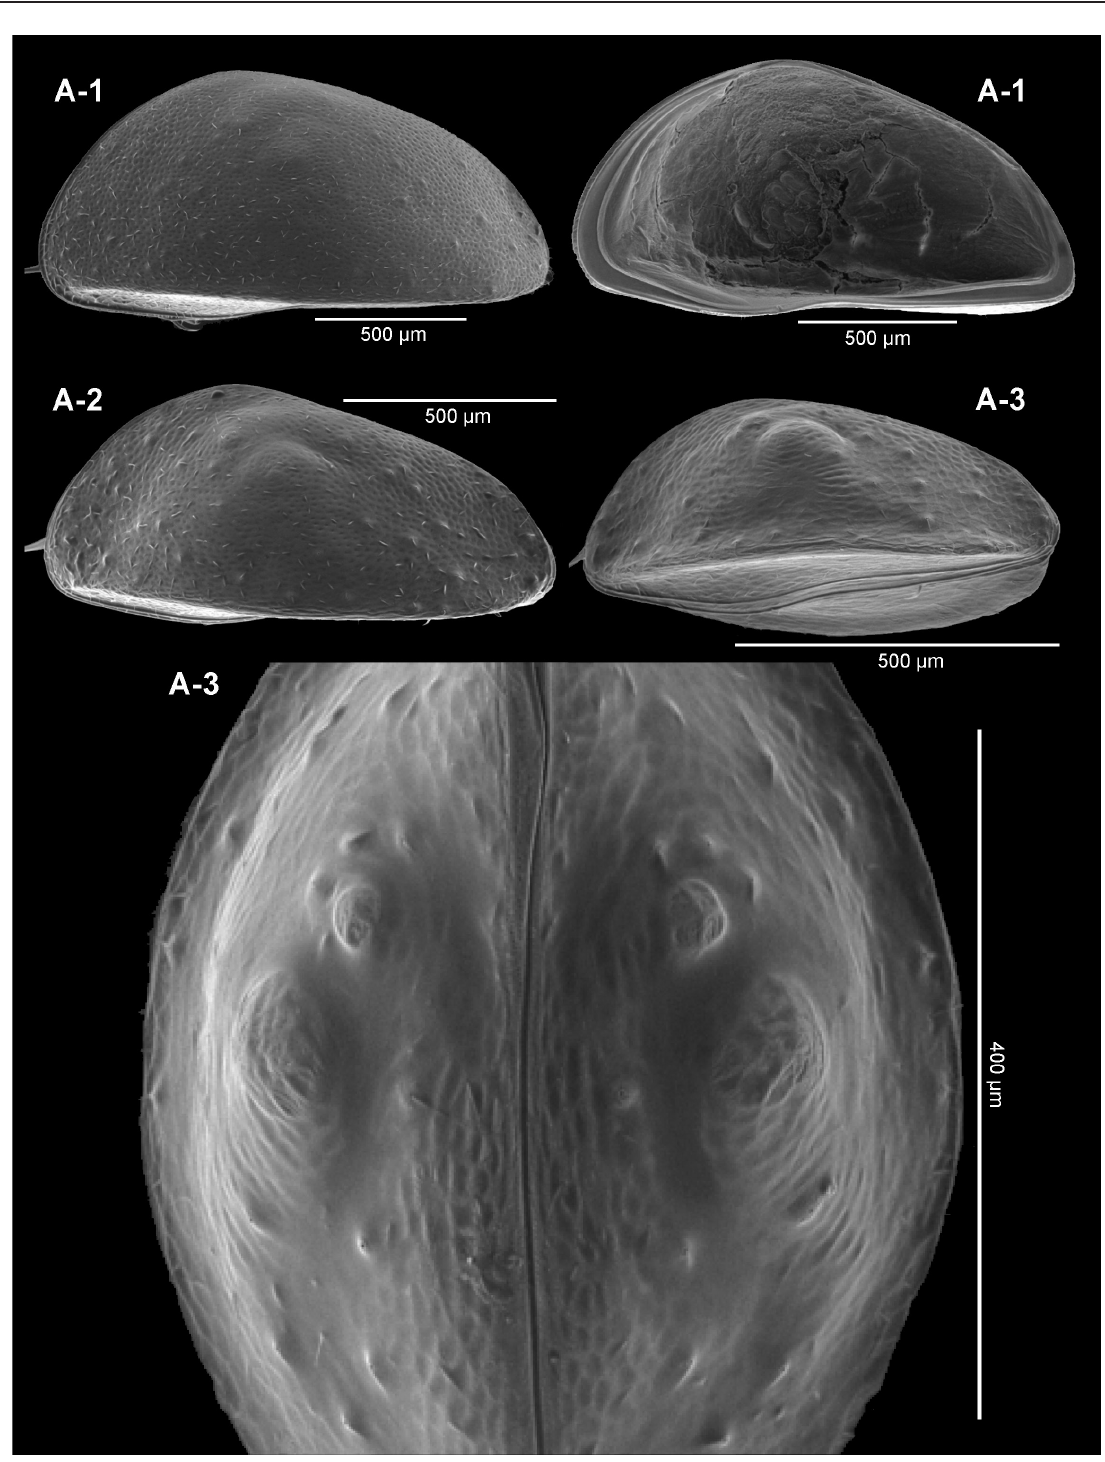
Fig. 12. Bennelongia sp. 414 nov. sp. from locality CB35a at Wooramel Station (Halse et al . 2000). All views are external, except for the right valve displayed at the top right hand corner. As for Figure 11, note that the domes and cones are much more discrete. This is particularly obvious in the bottom image that displays a dorsal view of the carapace of an A-3 juvenile. Note also that the internal view does not show a depression at the location of the dome. The middle right image shows the obvious lateral ridge that defines this new